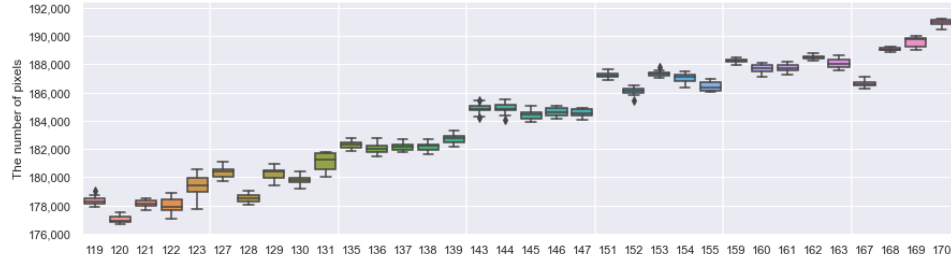
Figure A3. 27 August–2 September.